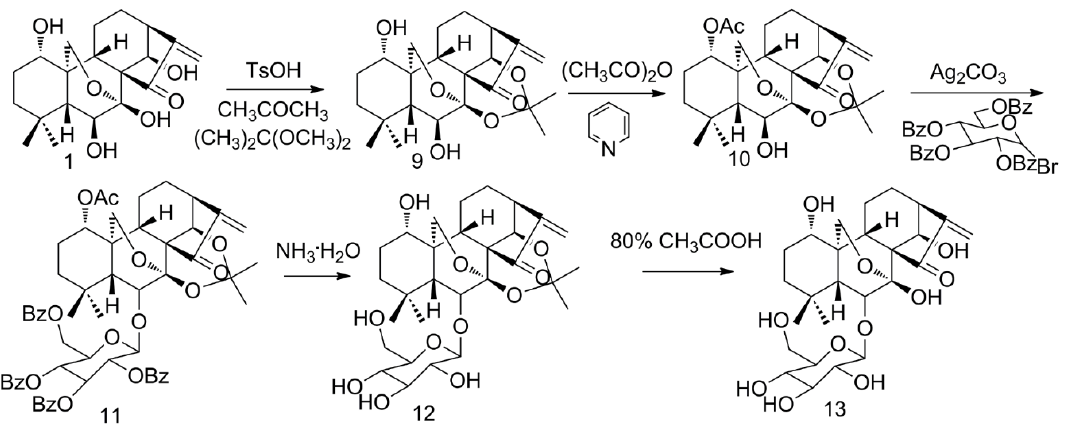
Figure 3. Synthesis of ORI-6- O -β- D -glucopyranoside.